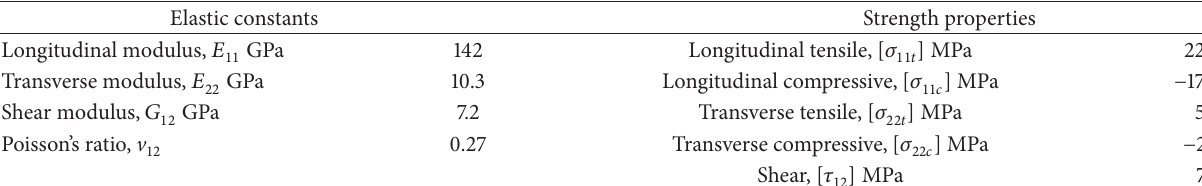
Table 7: Mechanical properties of AS4/3501-6 lamina—source [10].